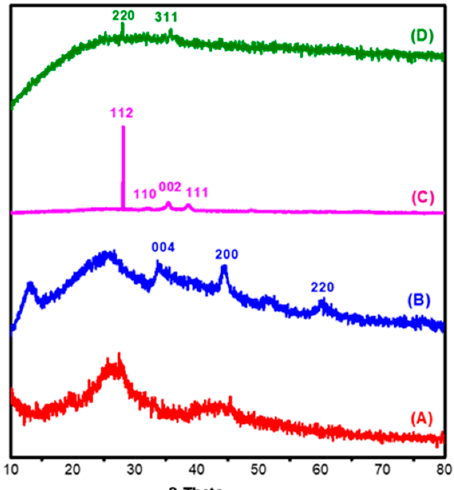
Figure 2. XRD pattern for ( A ) Acell, ( B ) nNiO/Acell, ( C ) nCuO/Acell and ( D ) nFe 3 O 4 /Acell nanocomposite.